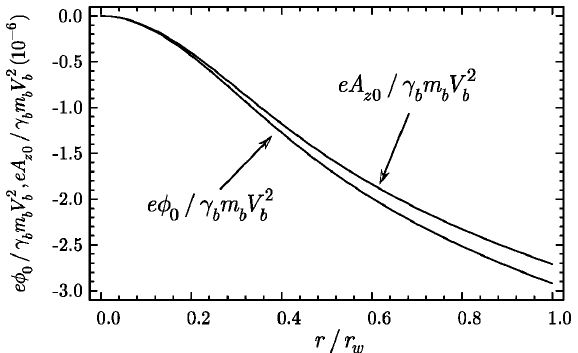
FIG. 1. Plots of the normalized equilibrium self-field poten- tial